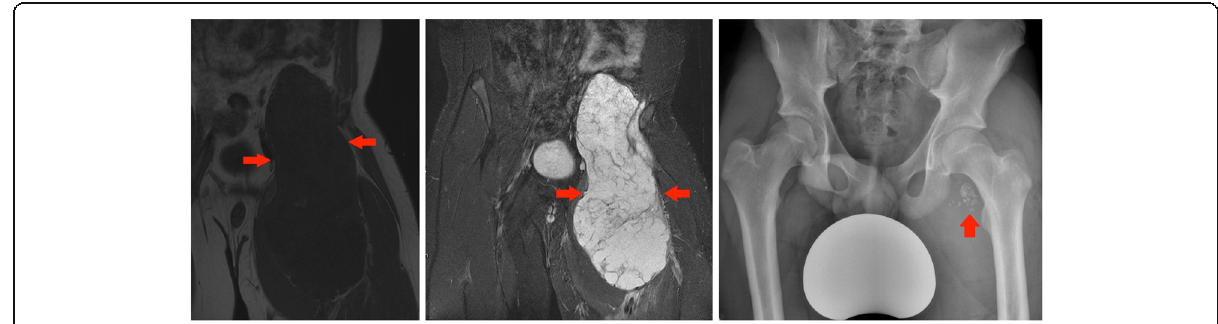
Fig. 17 Left panel: Coronal T1-weighted image of the pelvis and upper thigh: large low signal intensity mass is seen in the left iliopsoas compartment (red arrows). This demonstrates a paucity of fat signal. Middle panel: Coronal T1 TIRM image of the pelvis and upper thigh: a high signal intensity is seen in the tumour with low signal septations and an overall aggressive appearance. Right panel: AP X-ray of the pelvis: red arrow confirms an area of intra-lesional chondroid calcifications. Biopsy confirmed a high-grade chondrosarcoma. Intra-operatively the tumour appeared to be originating from the lesser